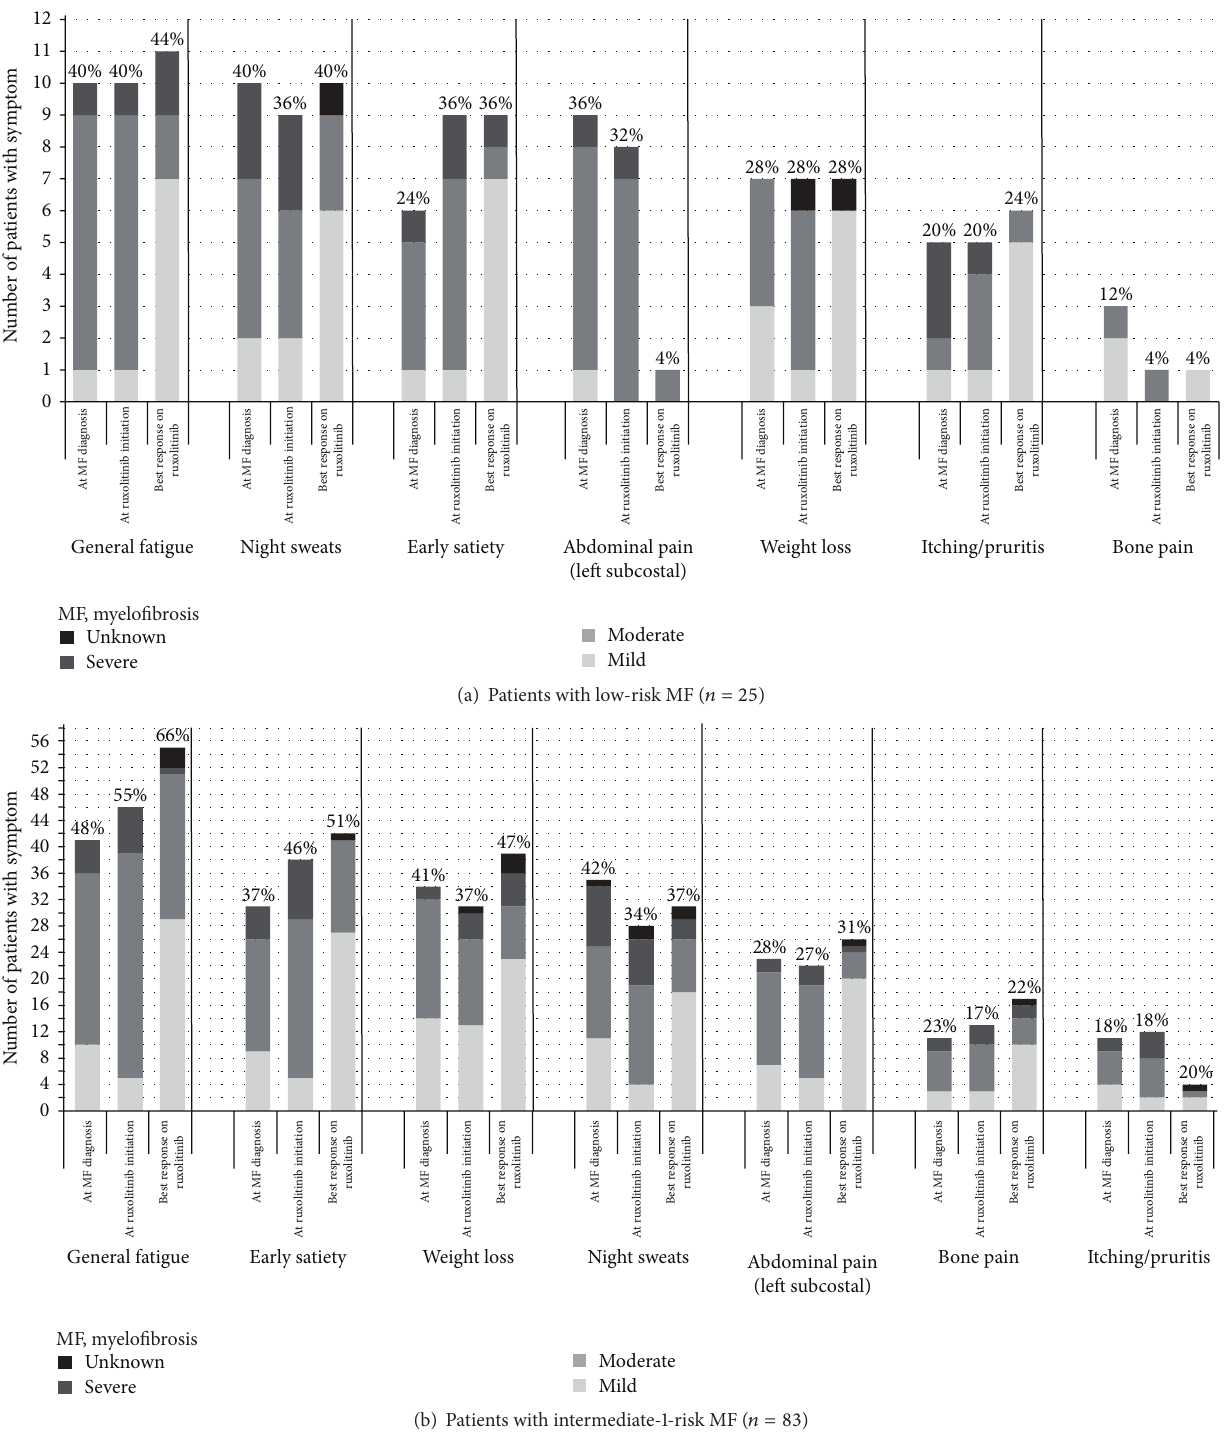
Figure 2: Symptom frequency and severity